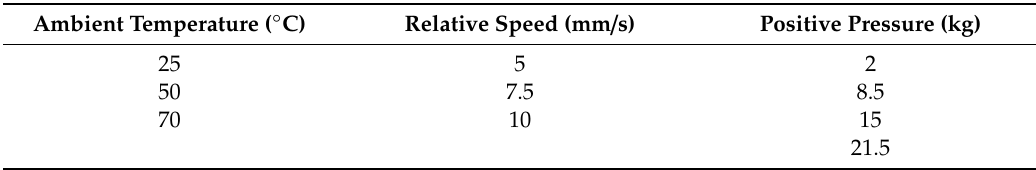
Table 1. Experimental parameters and their corresponding